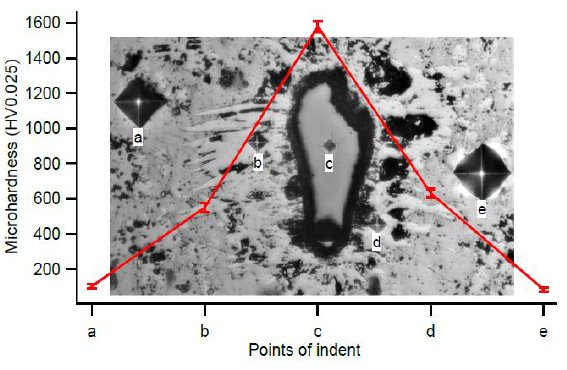
Figure 9. Comparison of the macrohardness of un-reinforced and Fe/B 4 C composites with varied durations of sintering.